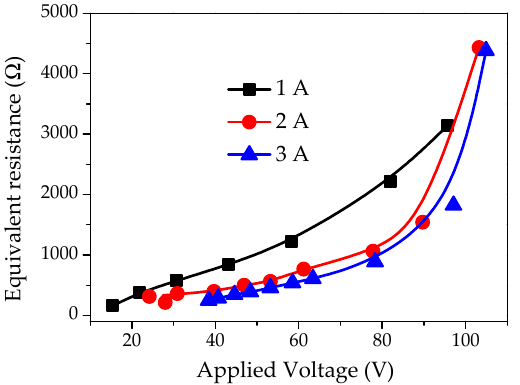
Figure 11. Equivalent parallel resistance (for 50 Hz), which is designated as magnetic core losses.